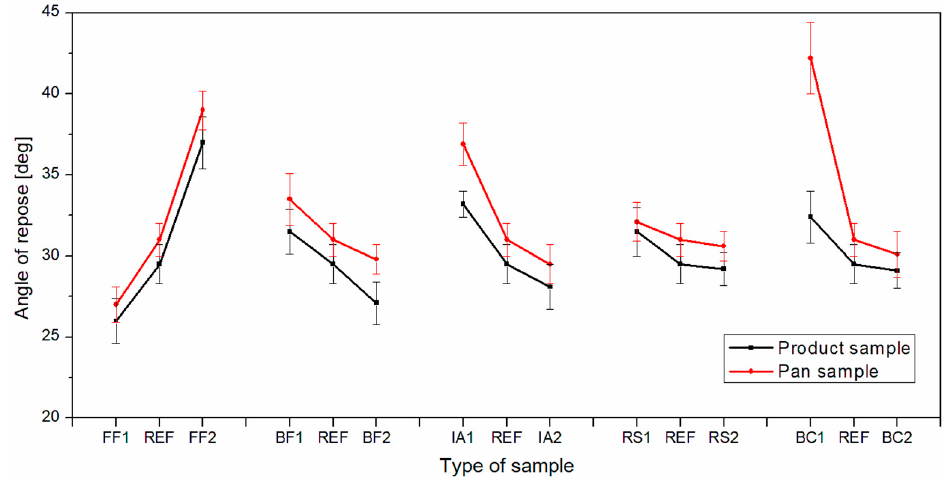
Figure 13. Influence of the operating parameters on angle of repose.